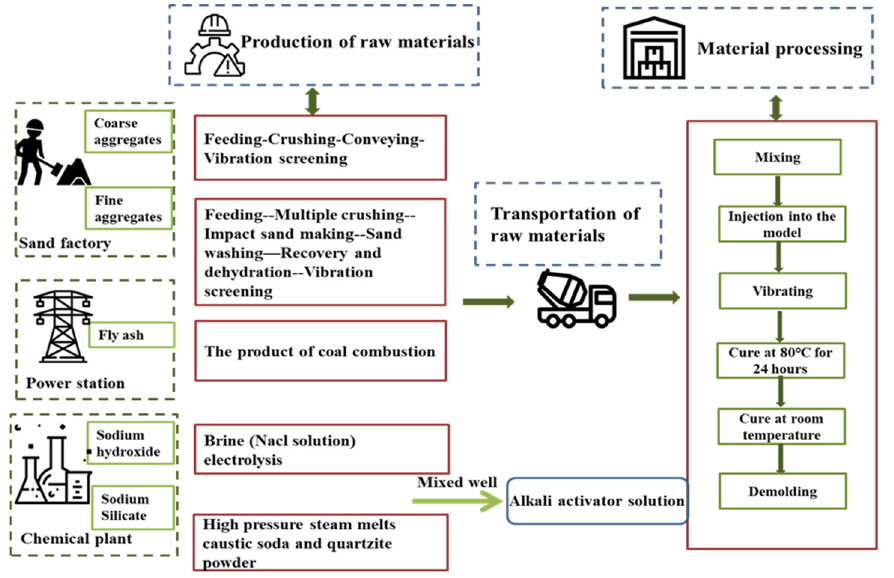
Figure 1. System scope of life cycle assessment.